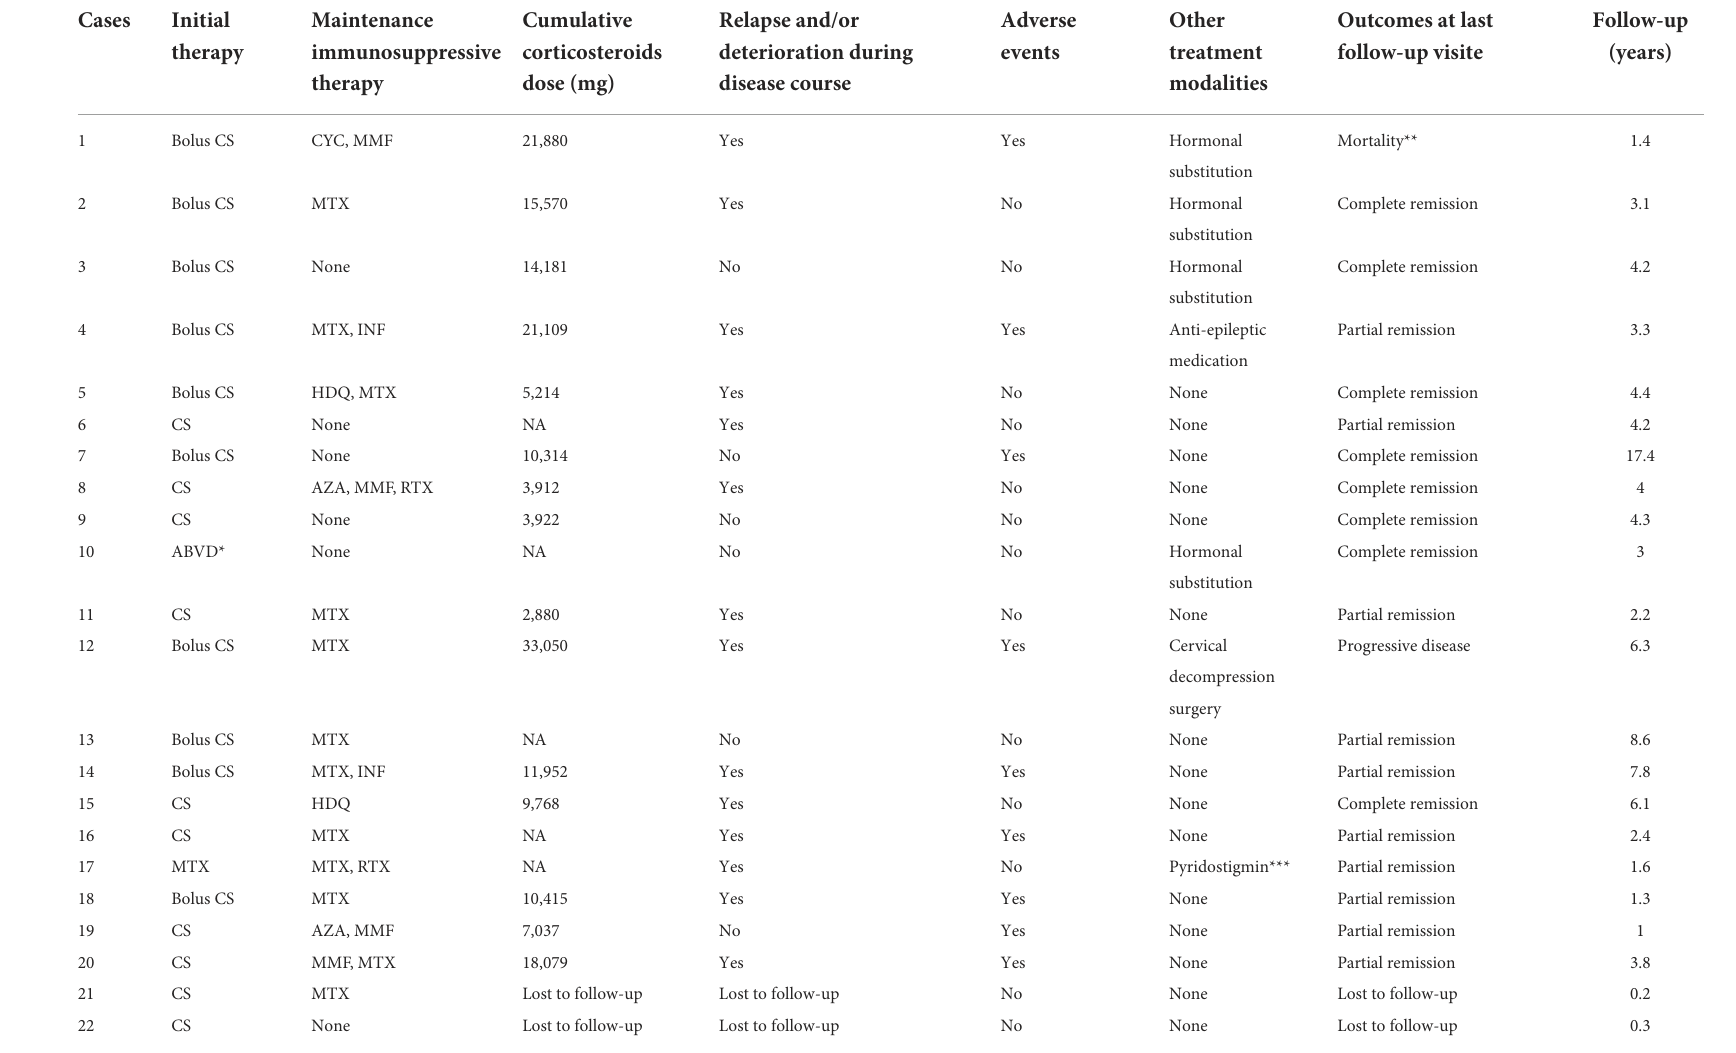
TABLE 4 Treatment and clinical outcomes of our patient cohort.